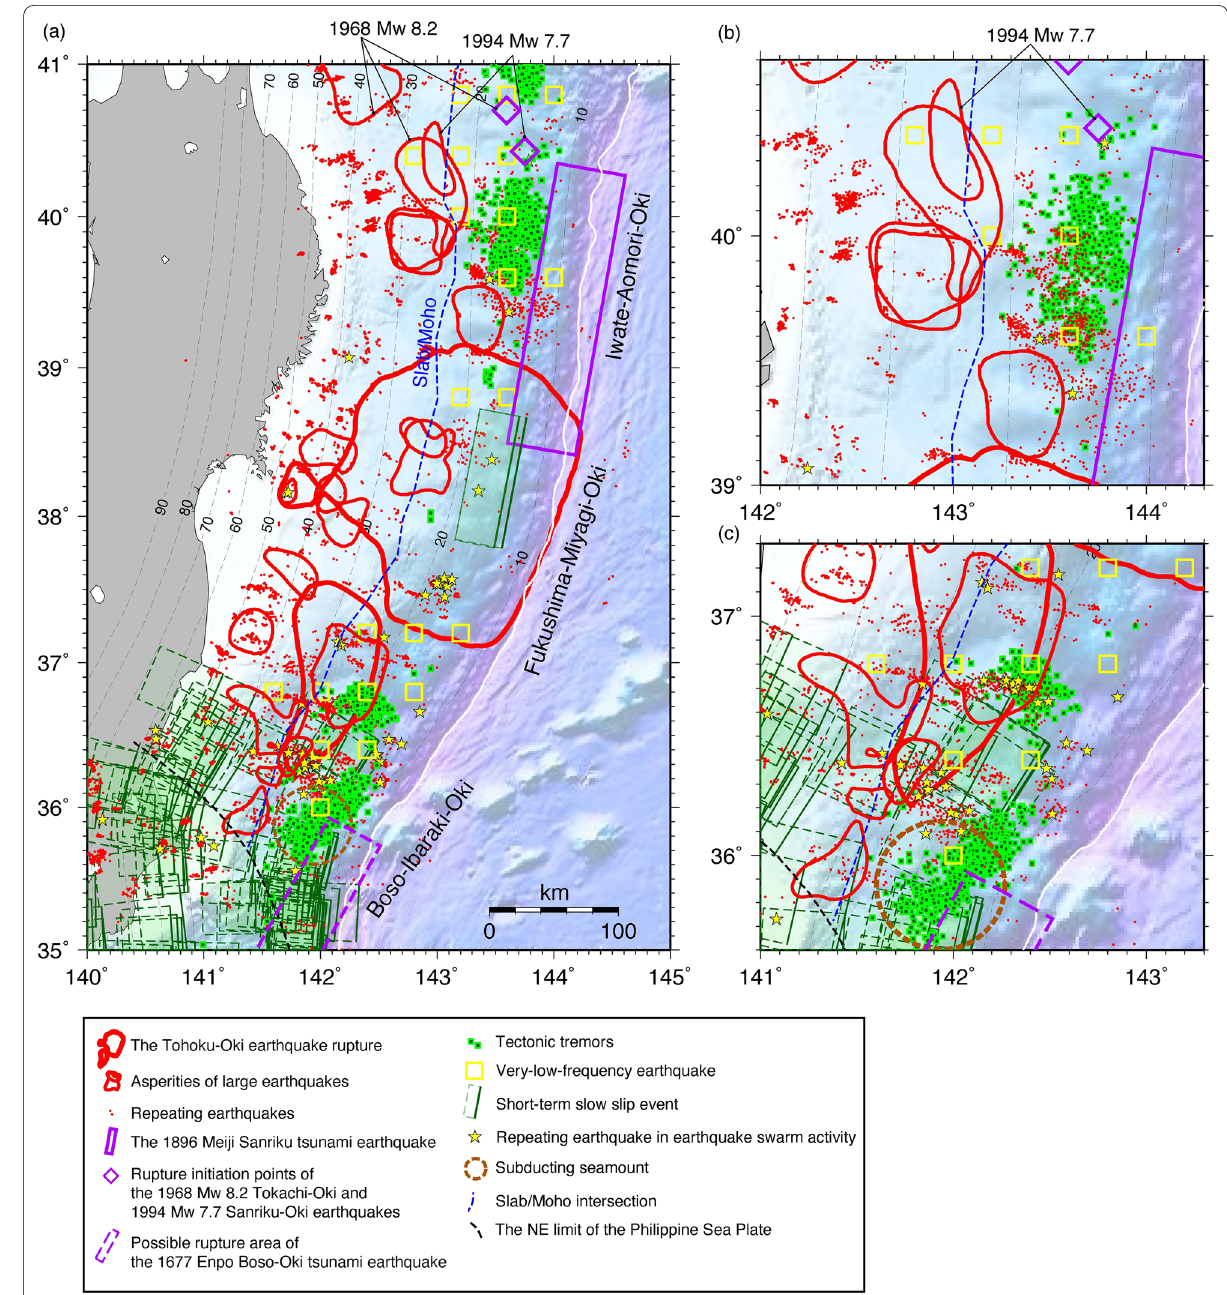
Fig. 9 Comparison between megathrust asperities and the slow earthquake distribution in the Japan Trench. a Megathrust asperities and epicenters of the slow earthquakes. b and c Enlarged views of the northern and southern Japan Trench, respectively. For an explanation of the symbols, refer to the legend in the figure. The megathrust asperities are from Nagai et al. (2001), Murotani et al. (2003), Yamanaka and Kikuchi (2004), Earthquake Research Center (2005), Mochizuki et al. (2008), Research Center for Seismology, Volcanology, and Disaster Mitigation (2008), Ohta et al. (2012), Kubo et al. (2013), and Kubo and Nishikawa (2020). The slip distribution of the March 11, 2011, Tohoku-Oki earthquake and the 1896 Meiji Sanriku tsunami earthquake is from Iinuma et al. (2012) and Tanioka and Seno (2001), respectively. The rupture initiation points of the 1968 M w 8.2 Tokachi-Oki and 1994 M w 7.7 Sanriku-Oki earthquakes are from the JMA catalog. The possible rupture area of the 1677 Enpo Boso-Oki tsunami earthquake is based on the Japan Society of Civil Engineers (2002). Small repeating earthquakes are from Uchida and Matsuzawa (2013). Repeating earthquakes included in earthquake swarms are based on Nishikawa and Ide (2018) and Nishikawa et al. (2019). Tectonic tremors are from Nishikawa et al. (2019) and this study. The VLFEs are from Baba et al. (2020). Short-term SSEs are from Ito et al. (2013), Nishimura (2021), and this study. The location of the subducting seamount in the southern Japan Trench is based on Mochizuki et al. (2008). The northeastern limit of the Philippine Sea Plate is from Uchida et al. (2009a). The intersection of slab and upper-plate Moho is based on Bassett et al.